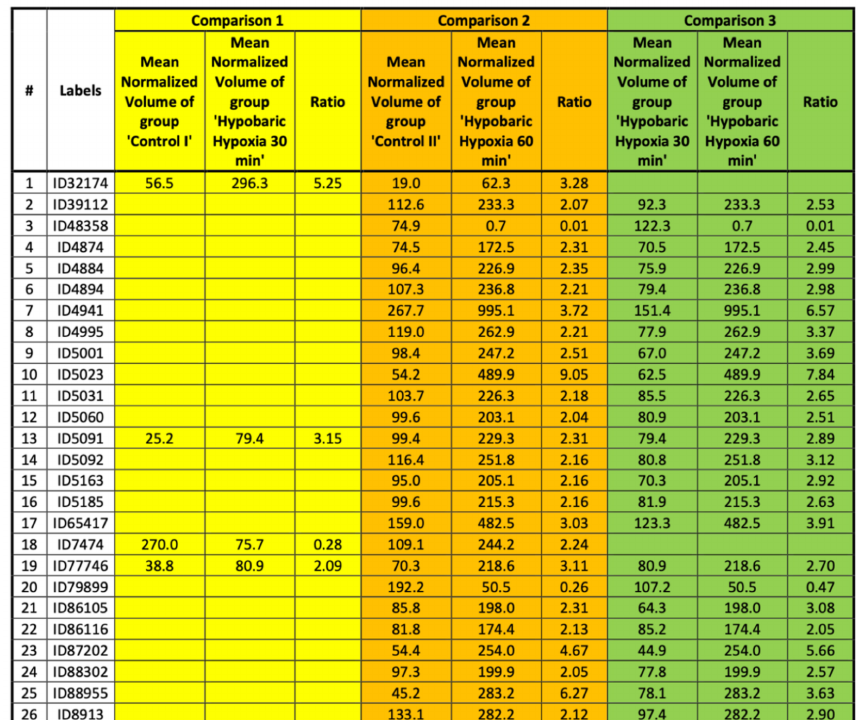
Figure 13. Spots found changed in more than one comparison.